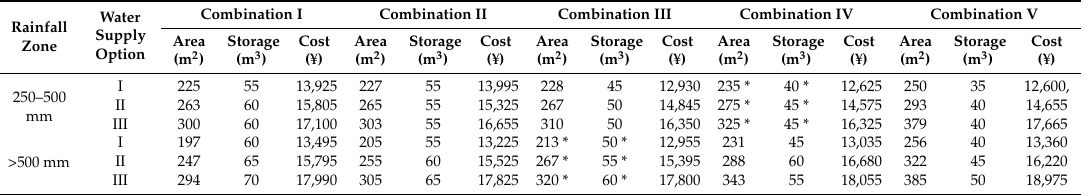
Table 7. Optimum design combinations and construction costs of safe rural domestic water systems. Rainfall